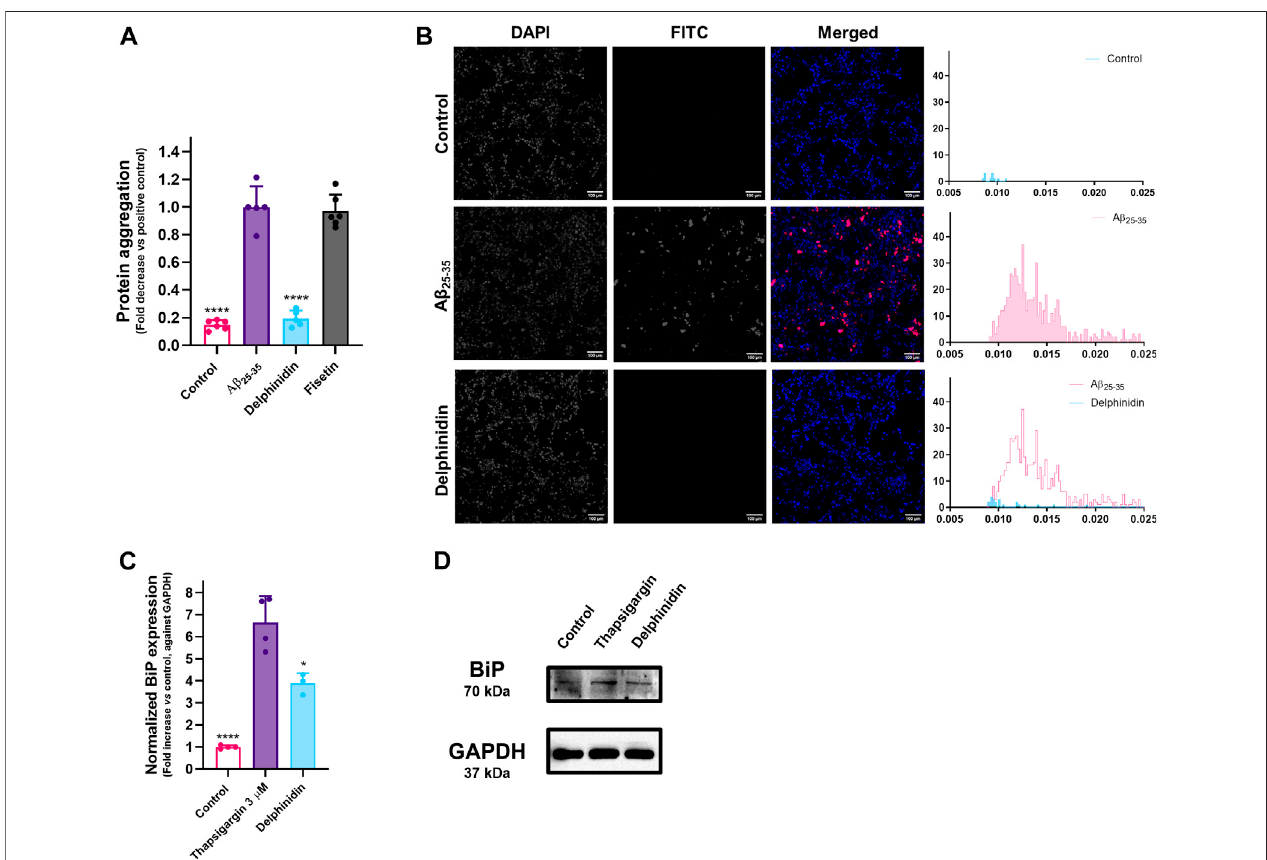
FIGURE 6 | (A) Effect of delphinidin and fi setin on A β 25-35 -induced protein aggregation in SH-SY5Y cells, as evaluated by determination of the fl uorescence of thio fl avin T. Results correspond to the mean ± standard error of the mean of, at least, three independent experiments, each performed in triplicate. (B) The effect of bioactive molecules wasobserved under a fl uorescence microscope. The fl uorescence signal of thio fl avin Tis represented in the histograms. (C) Effect ofdelphinidin on Tg-induced BiP expression in SH-SY5Y cells, as evaluated by Western blotting. Results correspond to the mean ± standard error of the mean of, at least, three independent experiments. (D) Example of the obtained Western blotting